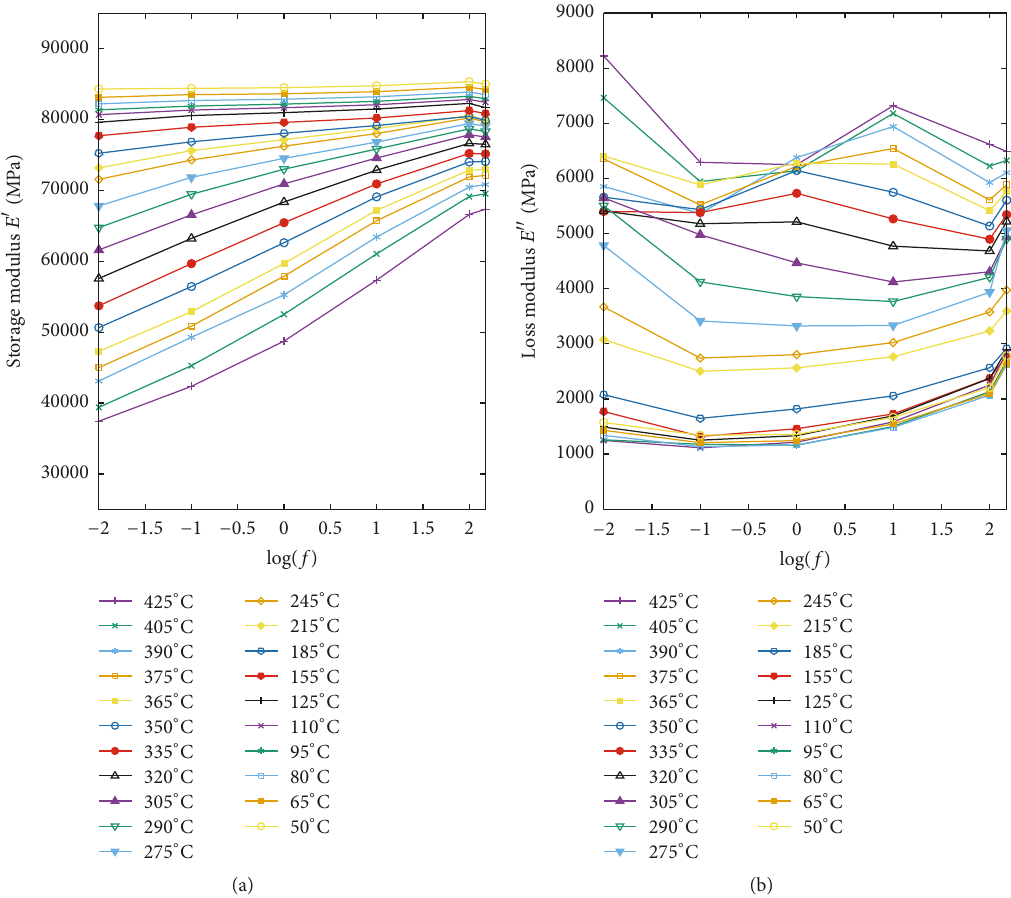
Figure 2: Isothermal storage modulus 𝐸 󸀠 (a) and loss modulus 𝐸 󸀠󸀠 (b) versus logarithm of the frequency 𝑓 from DMA tests on solution treated AA 7075 at frequencies ranging from 0.01 to 150Hz and from 50 to 425 ∘